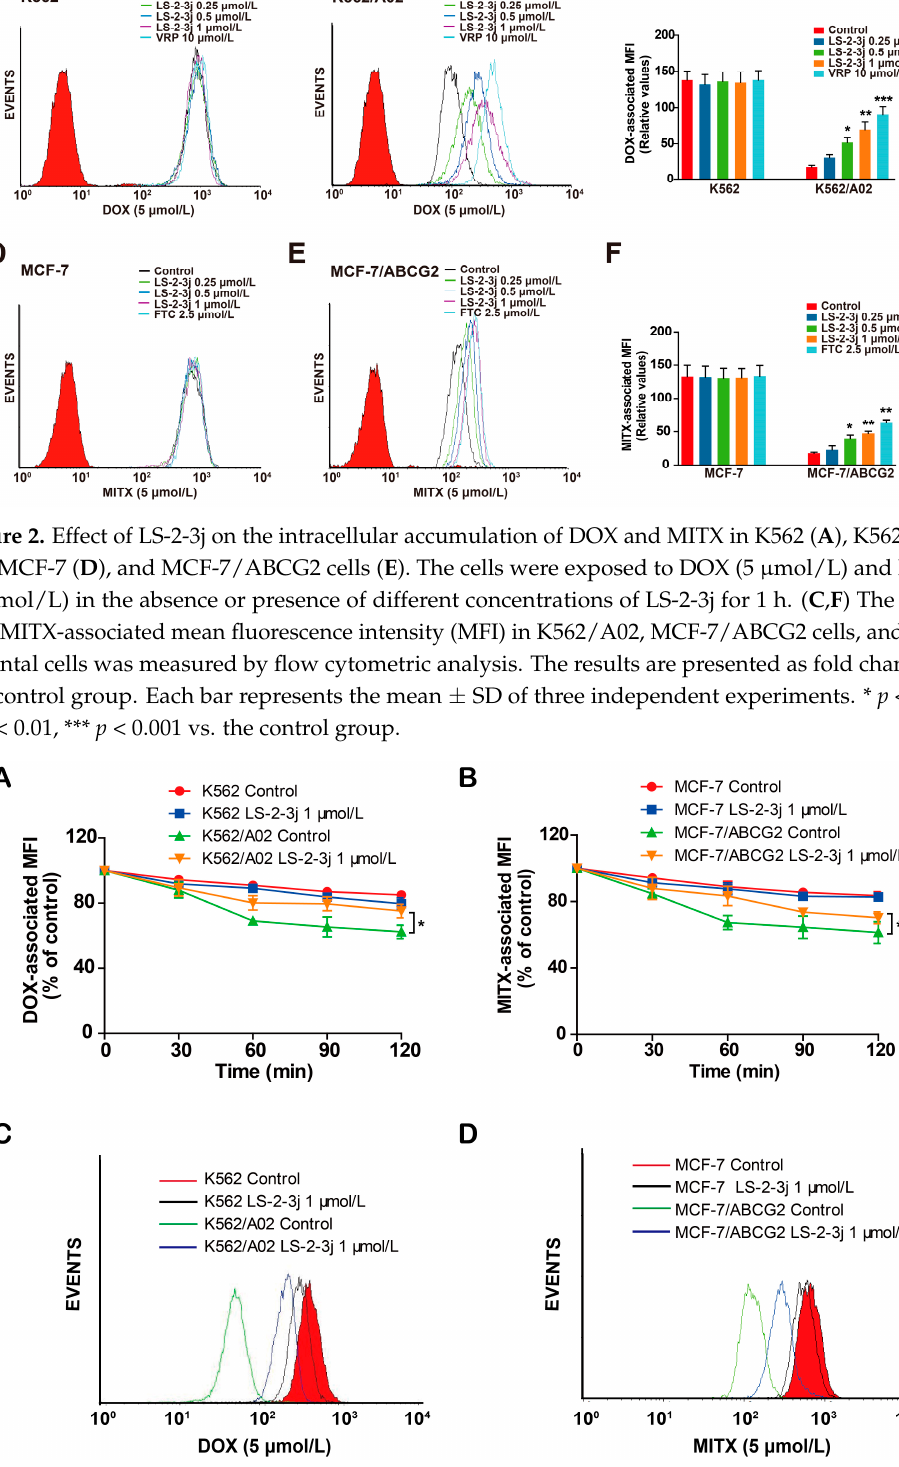
Figure 3. LS-2-3j inhibited the efflux of DOX and MITX. ( A , B ) The effect of LS-2-3j on the efflux of DOX and MITX in K562, K562/A02, MCF-7, and MCF-7/ABCG2 cells. ( C , D ) The corresponding